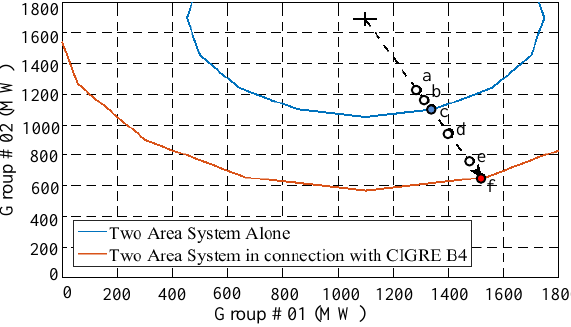
Figure 8. Security nomogram for (i) standalone Kunder’s AC network (blue lines) and (ii) interconnected AC/DC systems (red lines).